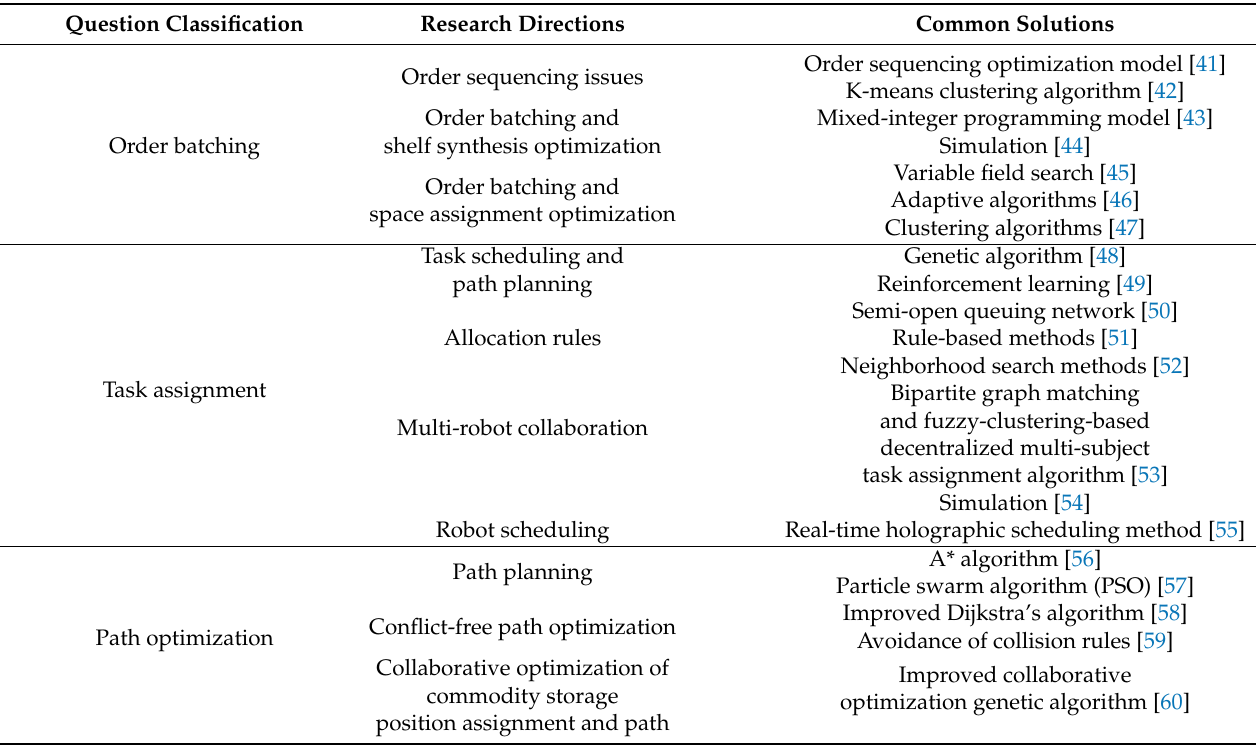
Table 1. Research status